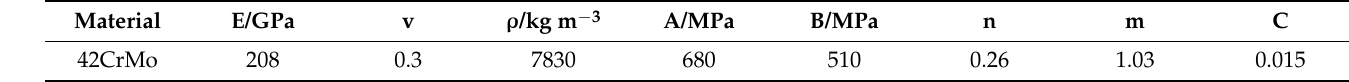
Table 1. The Johnson-Cook model parameters of 42CrMo steel